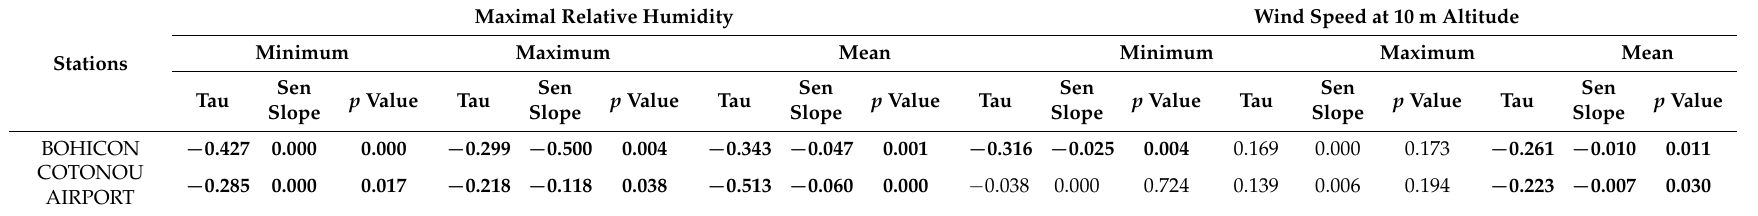
Table 11. Maxima relative humidity and wind speed at 10 m altitude trend based on annual minimum, maximum, and